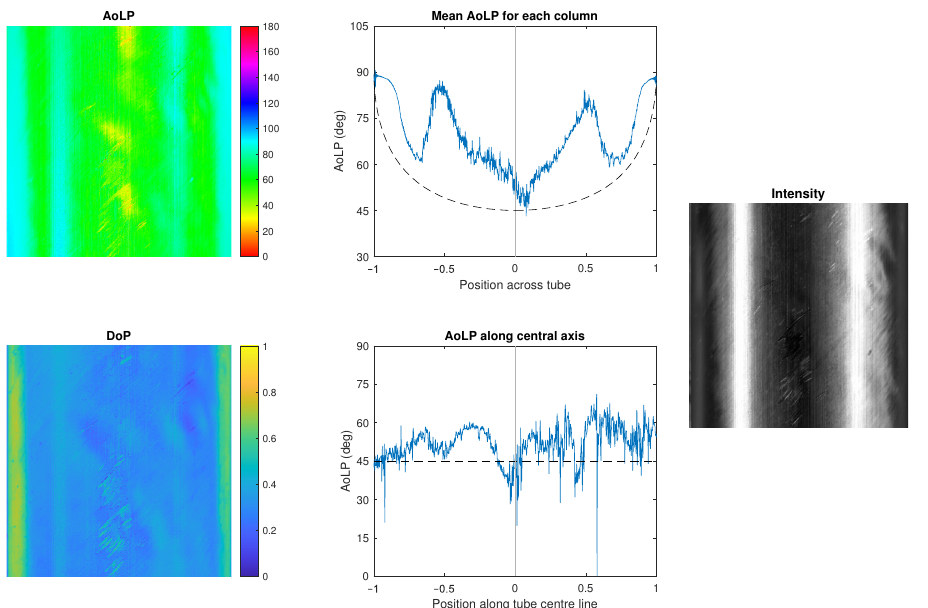
Figure 23. ( Left ): AoLP and DoP images for a UD cured tube under dark field illumination. Centre: Measured (solid) and theoretical predictions (broken) of AoLP across a slice of the tube and along its central longitudinal axis. ( Right ): Intensity image (shown to indicate the presence of specular reflections from the strip lights).